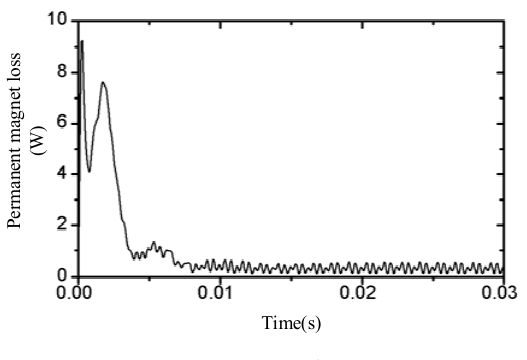
Figure 11. PM loss. Figure 11. PM loss.